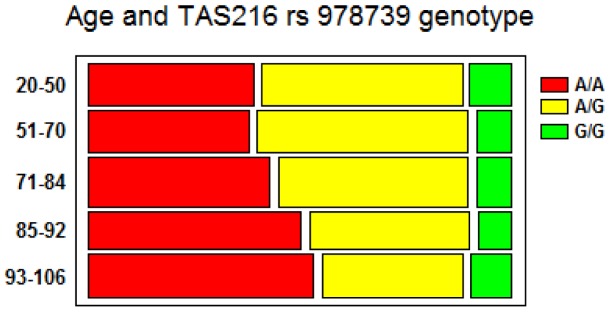
Bar chart of age by genotypes showing the association between the polymorphism of TAS2R16 rs 978739 and longevity.The A/A genotype frequency is about 40.5% in the young and adult classes (20–50 and 51–70 years). Thereafter the A/A frequency increases through older classes reaching the 55.5% in the oldest (χ2 = 17,08, p<0.029).